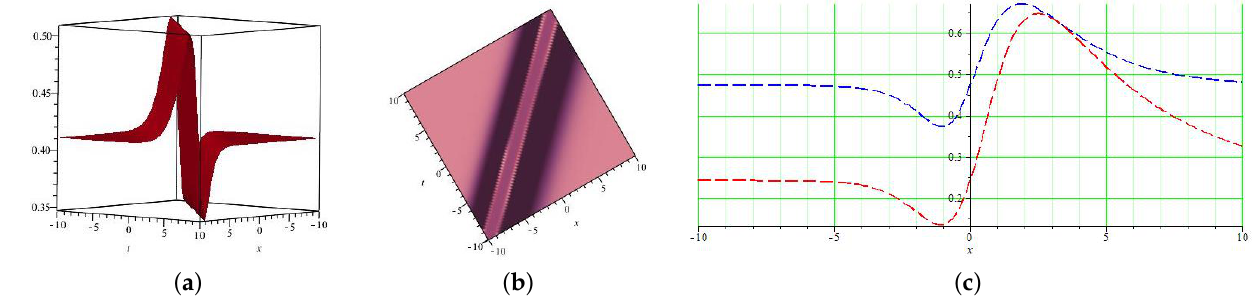
Figure 5. Graph of Z 7 . ( a ) 3D plot. ( b ) Contour plot. ( c ) 2D